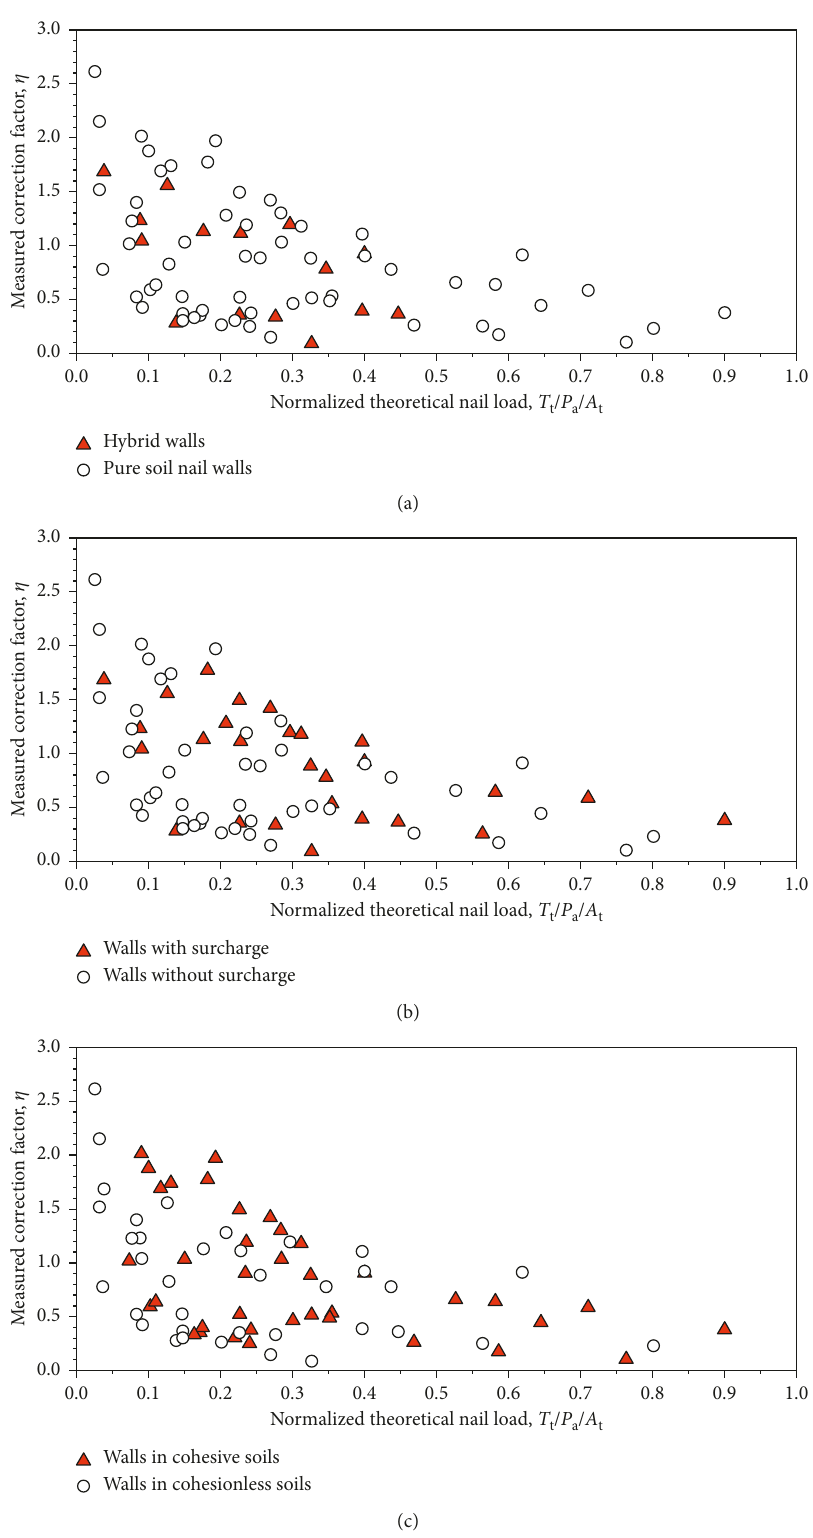
Figure 2: Measured correction factor η versus normalized theoretical nail load T wall-working